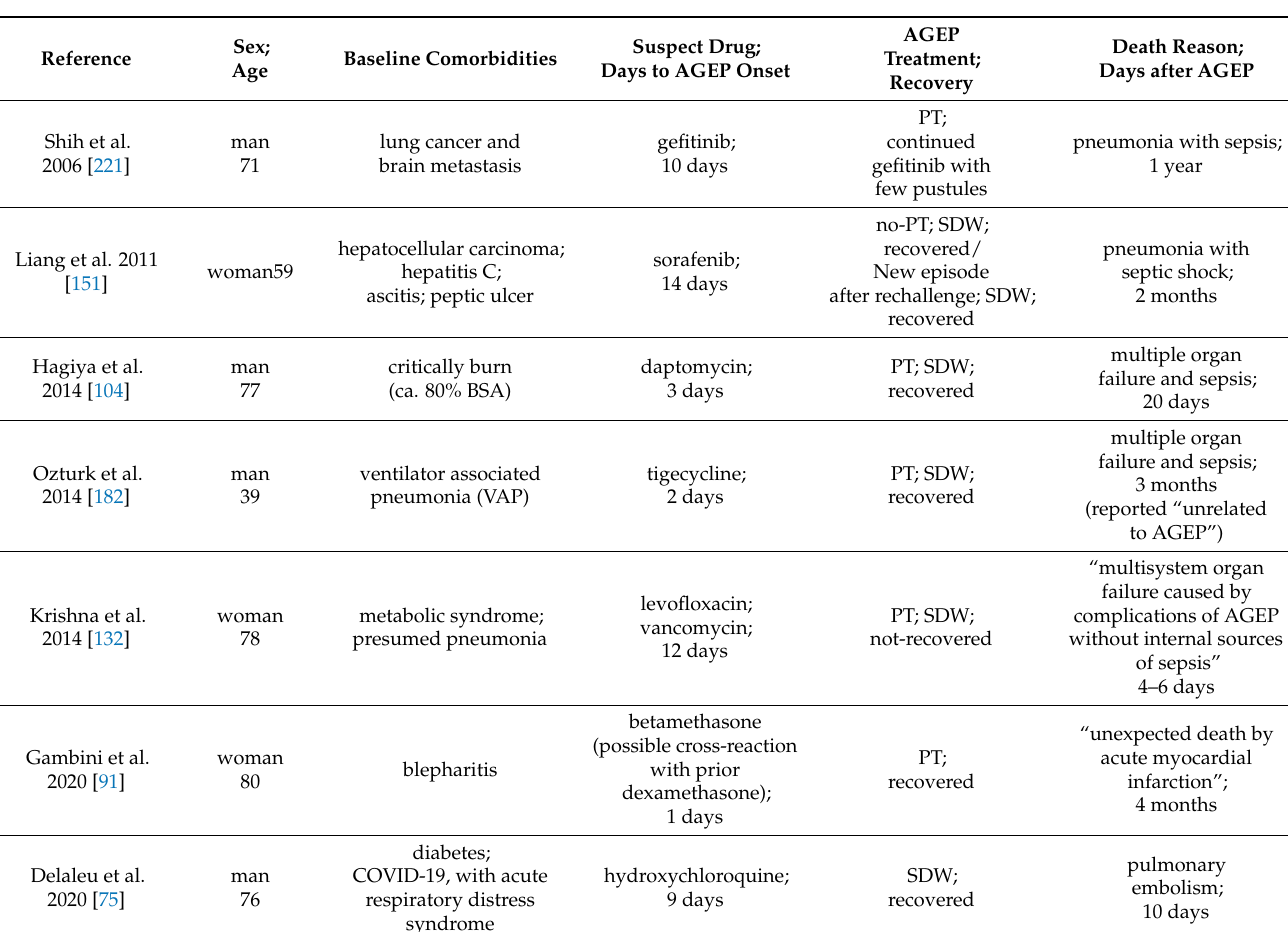
Table 2. Characteristics of the patients with reported death after acute generalized exanthematous pustulosis